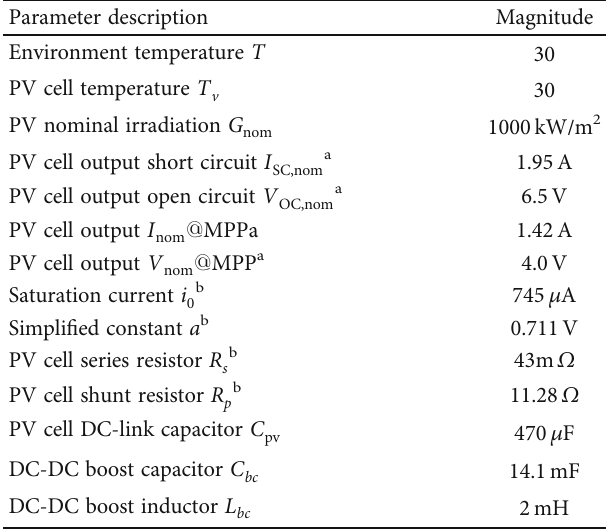
Table 1: Key parameters for simulation and